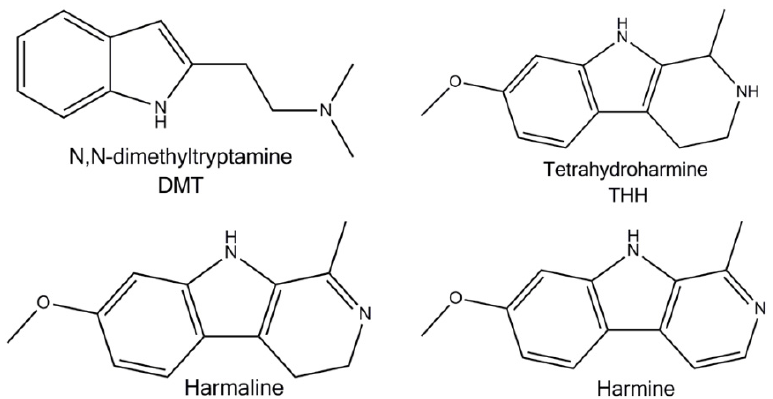
Figure 1. Psychedelic DMT and β -carbolines present in ayahuasca .